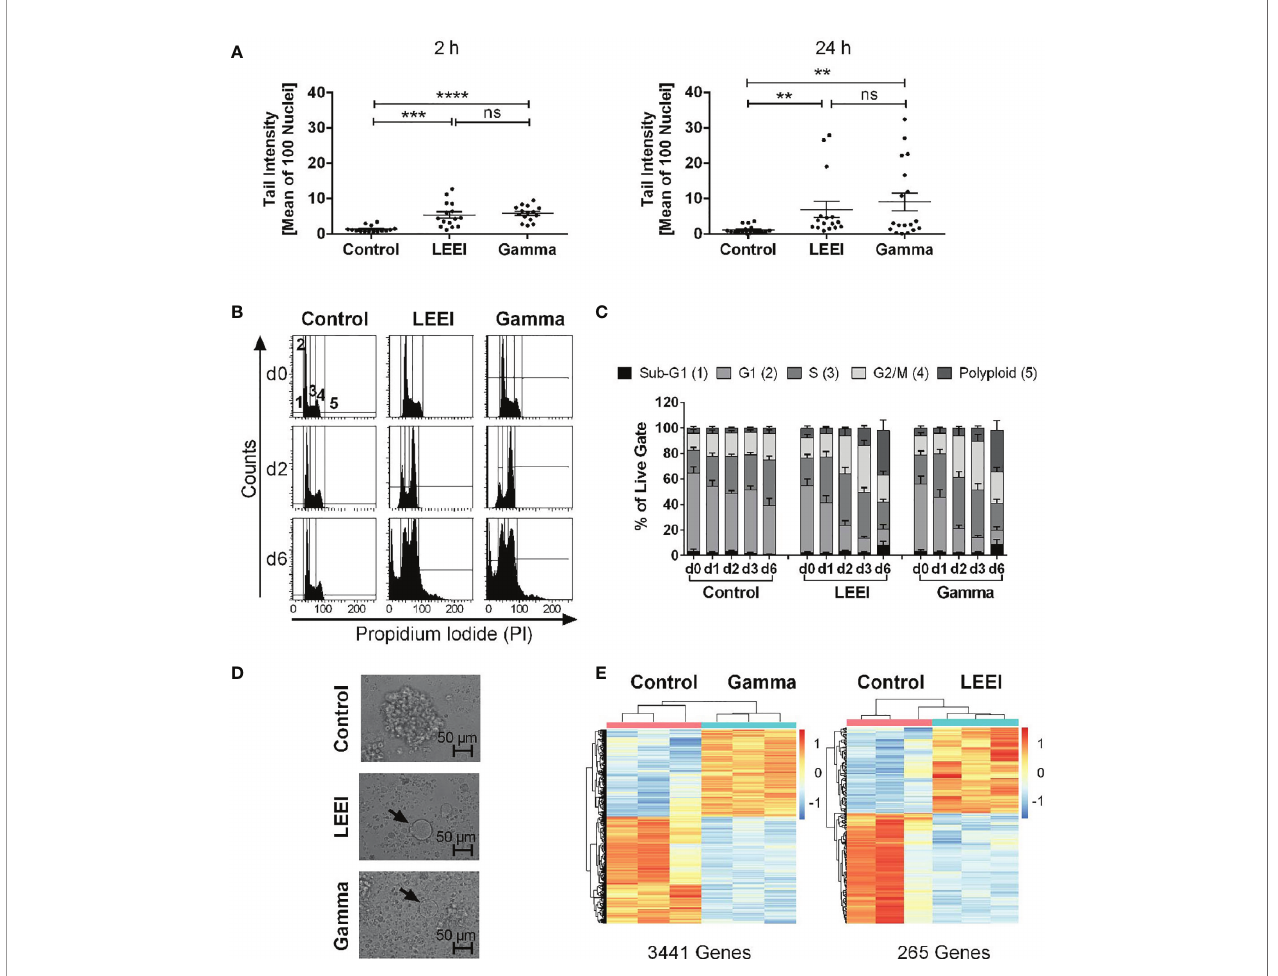
FIGURE 4 | Gamma irradiation and LEEI result in DNA damage and an accumulation in G2/M phases of CD123-directed CAR-NK-92 cells. (A) Alkaline comet assays were performed with LEE- and gamma-irradiated versus non-irradiated CD123-directed CAR-NK-92 cells 2 h (left) or 24 h (right) after treatment to determine irradiation-induced DNA strand breaks. Values are depicted as means ± SEM (n = 6 independent experiments, each carried out in technical triplicates, minimum number of 100 cell nuclei analyzed per sample). Statistical signi fi cance is symbolized by asterisks (ns for p > 0.05, * for p ≤ 0.05, ** for p ≤ 0.01, *** for p ≤ 0.001, and **** for p ≤ 0.0001, Kruskal-Wallis test adjusted for multiple comparisons by Dunn ’ s test). (B) CD123-CAR-NK-92 cells (n = 8) were fi xed and stained with propidium iodide (PI). Representative histograms of non-irradiated (control, left), LEE-irradiated (middle), and gamma-irradiated (right) cells are shown 2 h (d0, top), 2 days (d2, middle), and 6 days (d6, bottom) after treatment. Gating indicates cells de fi ned as Sub-G1- (1), G1- (2), S- (3), G2/M phase (4) or polyploid (5). (C) Quanti fi cation of PI- staining of CD123-directed CAR-NK-92 (n = 8). Values are indicated as means ± SEM. (D) Light microscopy of non-irradiated (control, top), LEE-irradiated (center), and gamma-irradiated (bottom) CD123-directed CAR-NK-92 cells on day 10 post-irradiation. Arrows show enlarged cells. (E) Preliminary results of gene expression levels of gamma-irradiated (left) and LEE-irradiated (right) CD123-directed CAR-NK-92 cells both compared to non-irradiated cells 2 h after treatment. Heat maps of normalized, variance-stabilized and per gene standardized expression values of three technical replicates show up- (red) or down-regulated (blue) genes. The total number of signi fi cantly differentially regulated genes is indicated below (FDR <